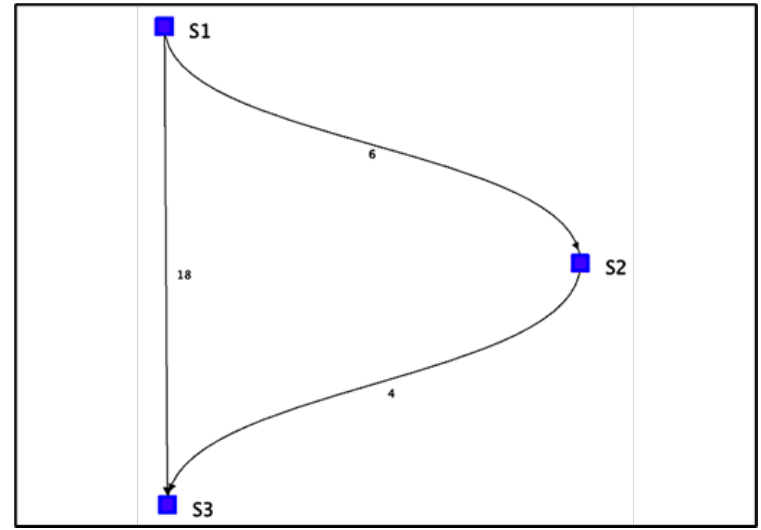
Figure 7. Algorithm 2 ’ s visualization of simulated path vectors.